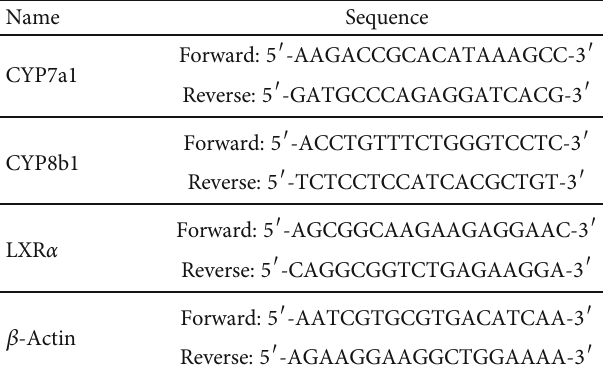
Table 1: The sequence information of primers used in this